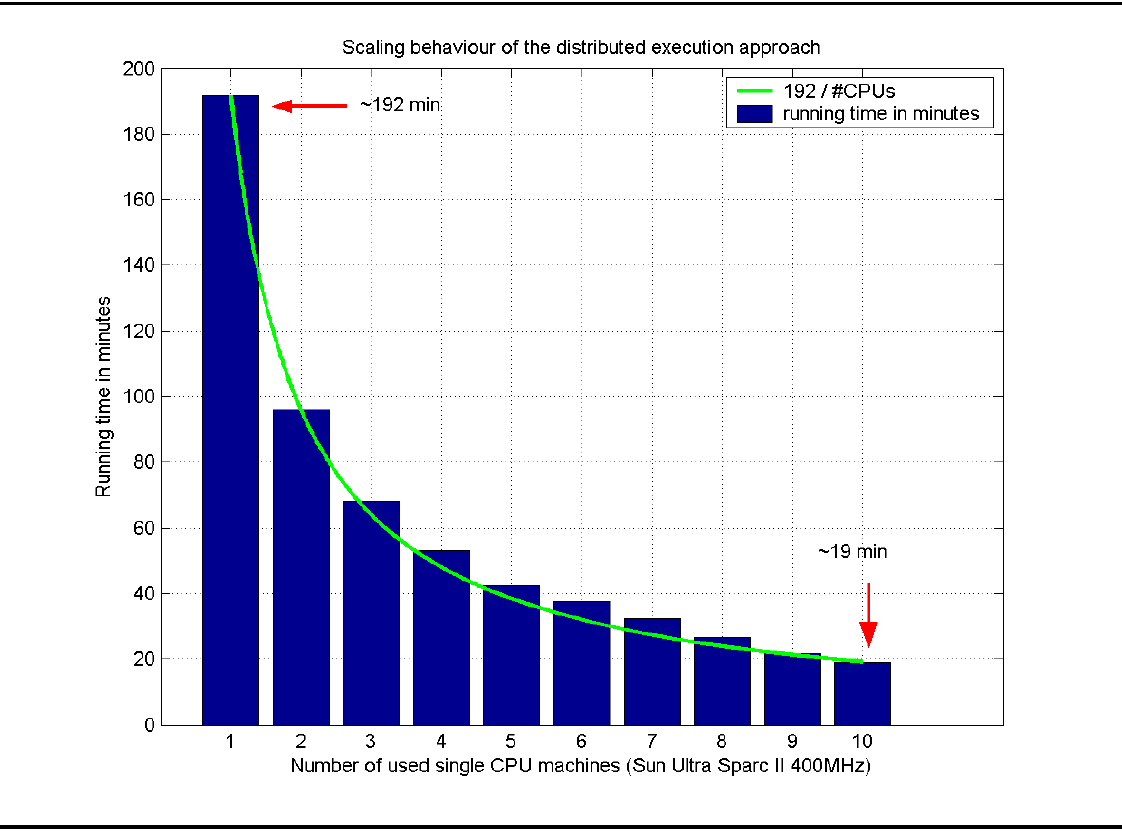
Figure 5: Scaling behavior of the distributed computing approach. Running times for a BLASTP comparison of the H. pylori J99 proteome (1487 proteins) and the SwissProt protein database (134803 sequences) depending on the number of used